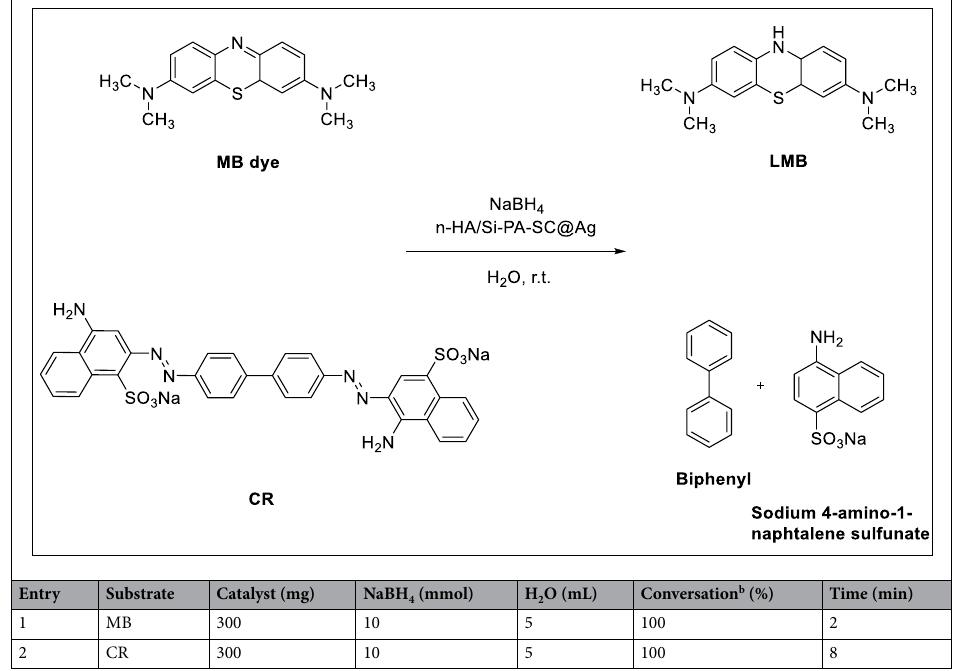
Entry Substrate Catalyst (mg) NaBH 4 (mmol) MB Table 2. Reduction of MB and CR catalyzed by n-HA/Si-PA-SC@Ag.